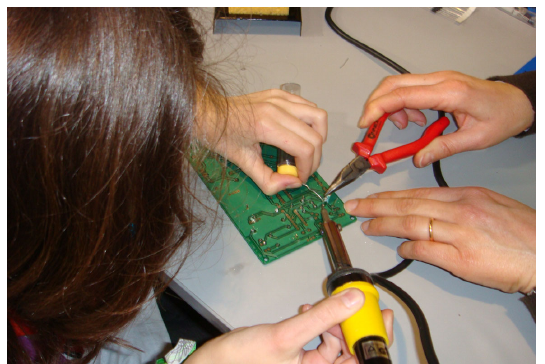
Figure 2. Soldering the components to build the robot